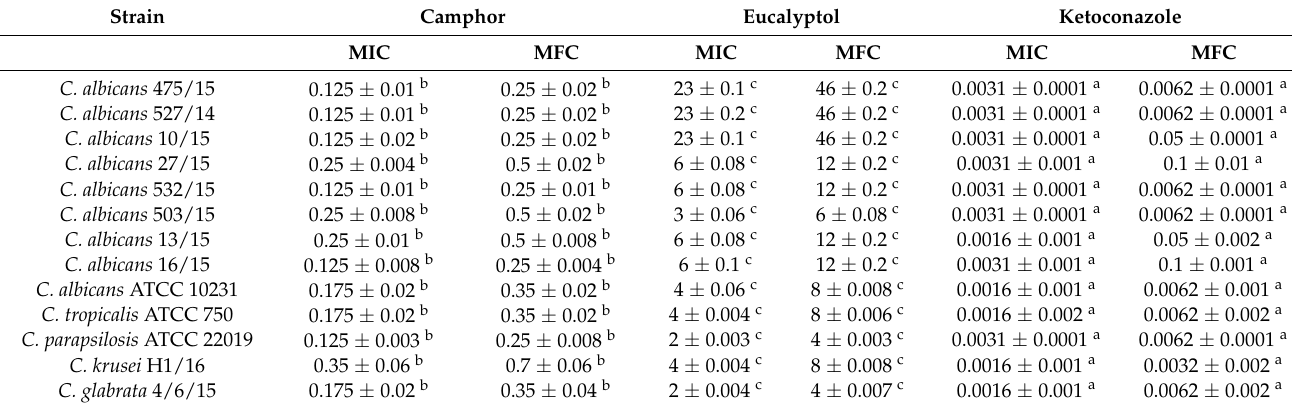
Table 1. Anticandidal activity of camphor and eucalyptol. Results are expressed in mg/mL. Values are expressed as means ± SD of three replicates. Different letters (a, b, c) in each row indicate a significant statistical difference between the samples ( p < 0.05). MIC and MFC values of the compounds are compared separately for each of the fungal strain tested.